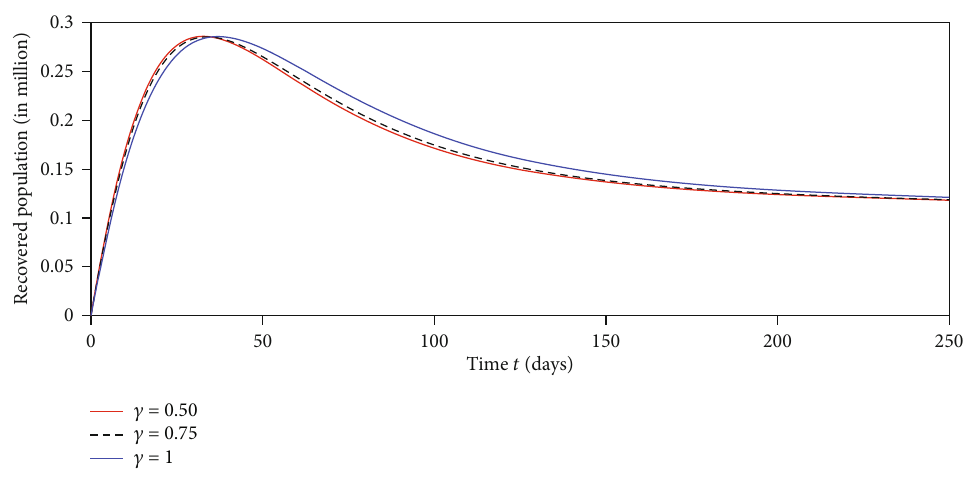
Figure 3: Graphical representation of the approximate solution of a recovered class at three di ff erent